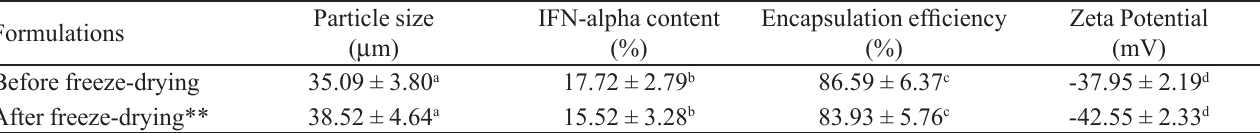
TABLE II - Characteristics of developed microspheres before and after freeze-drying* Formulations Before freeze-drying After freeze-drying**